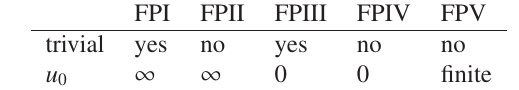
Table 1. Table of fixed points contained in the model.